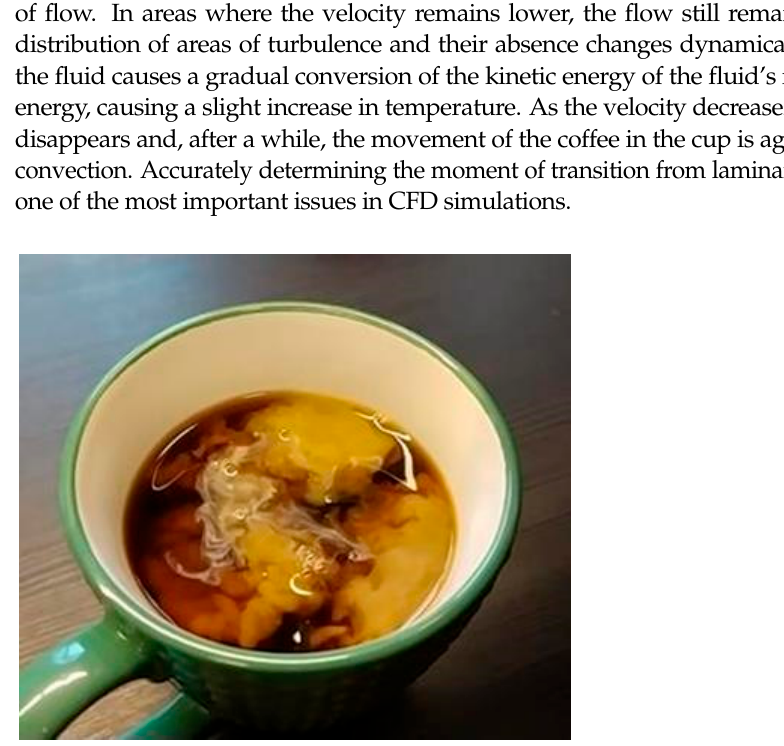
Figure 1. Coffee mixing with milk as an example of turbulent fluid motion.